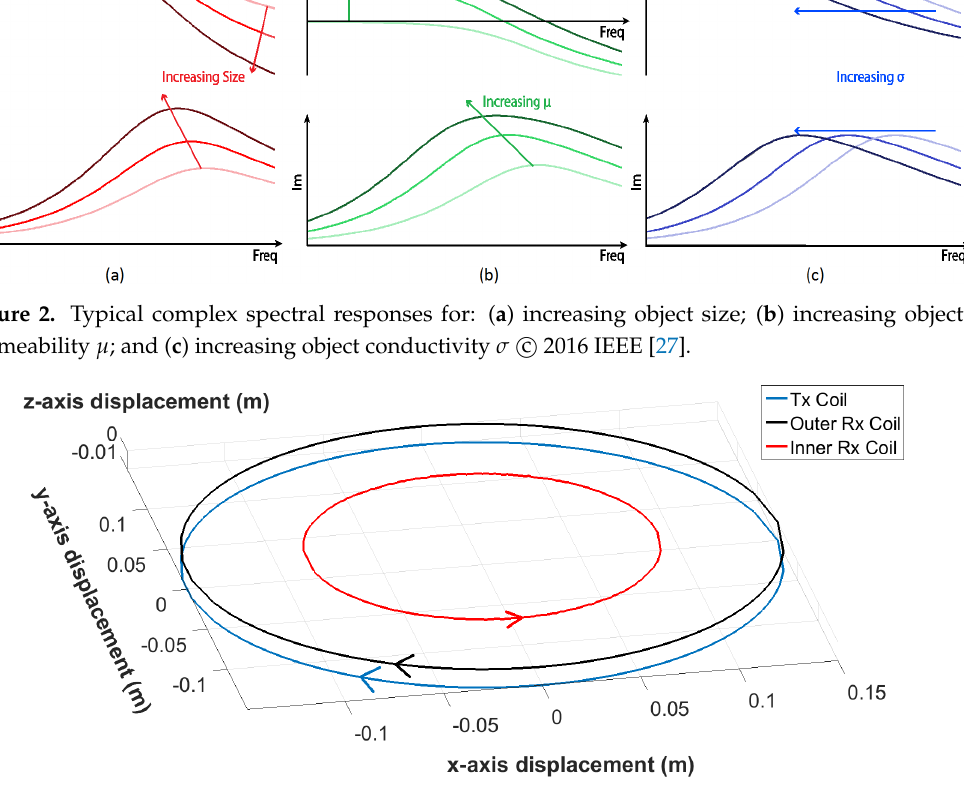
Figure 3. MIS sensor coil geometry including winding